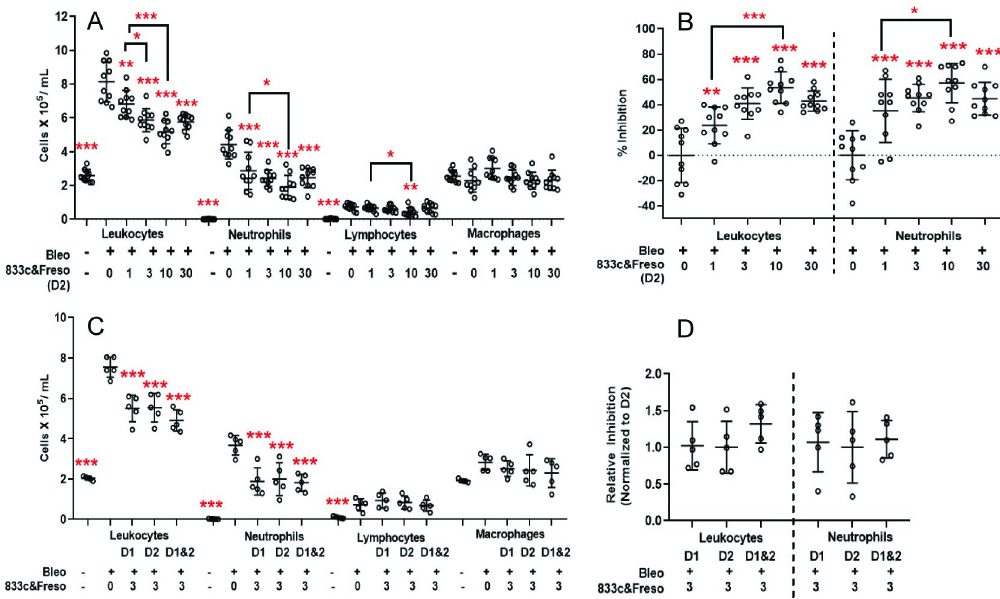
Fig 3. Therapeutic effects of 833&Freso on bleomycin-induced lung infiltration of inflammatory cells detected in BALf. 833c&Freso at the indicated doses ( μ g/kg) was injected iv into rats on the indicated days after bleomycin challenge (A-D) day 2 (D2), (C-D) day 1 (D1), (C-D) day 1 and 2 (D1&2)). BALf was collected on day 3. Total leukocyte and neutrophil count per ml of BALf (A,C) and percentage inhibition of the bleomycin effect on total leucocyte and neutrophil infiltration (B) . Data pooled from 2 independent experiments totaling n = 10 rats per group. (D) Relative inhibition is normalized to single treatment on D2, with n = 5 rats per group. Scatter graphs showing each data point with indicated means ± SD. � P < 0.03, �� P < 0.01, and ��� P < 0.001 vs. bleo only, by using one-way ANOVA followed by Dunnett’s test, except as indicated otherwise (A and B) when comparing dose differences with Student’s unpaired t test.